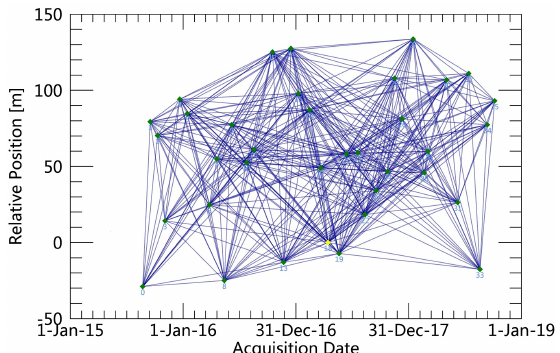
Figure 2. Spatiotemporal baseline distribution